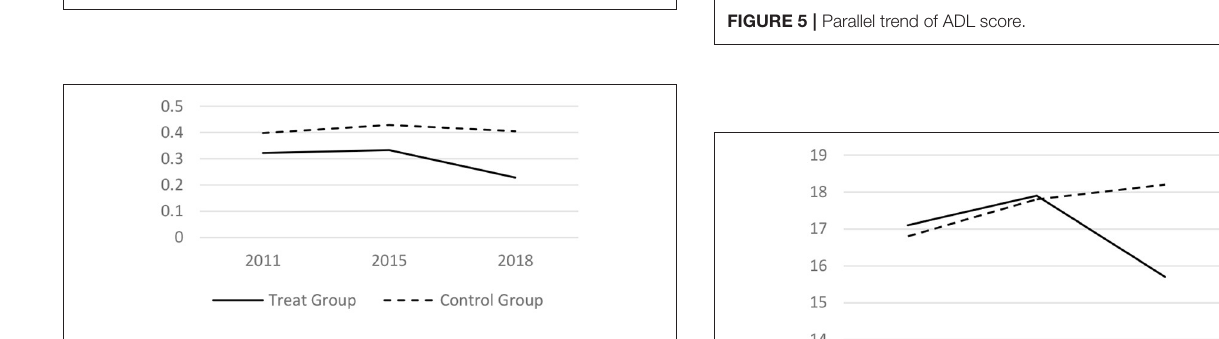
FIGURE 2 | Parallel trend of outexpatient frequency.